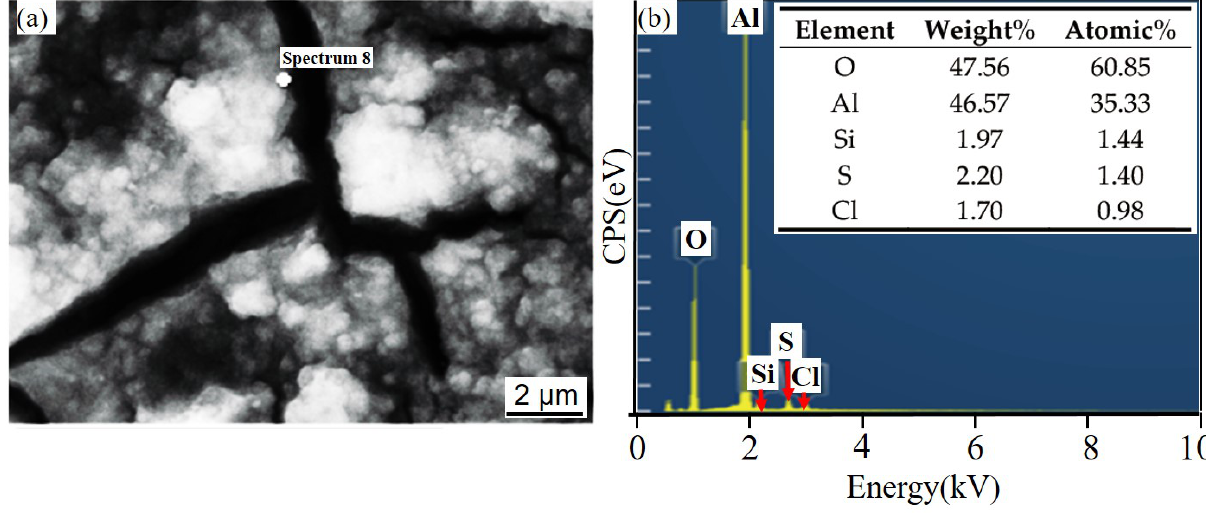
Figure 22. EDS of matrix cracks in 6061Al alloy after SL for 61 days. ( a ) SEM image of matrix cracks; ( b ) EDS of matrix cracks.